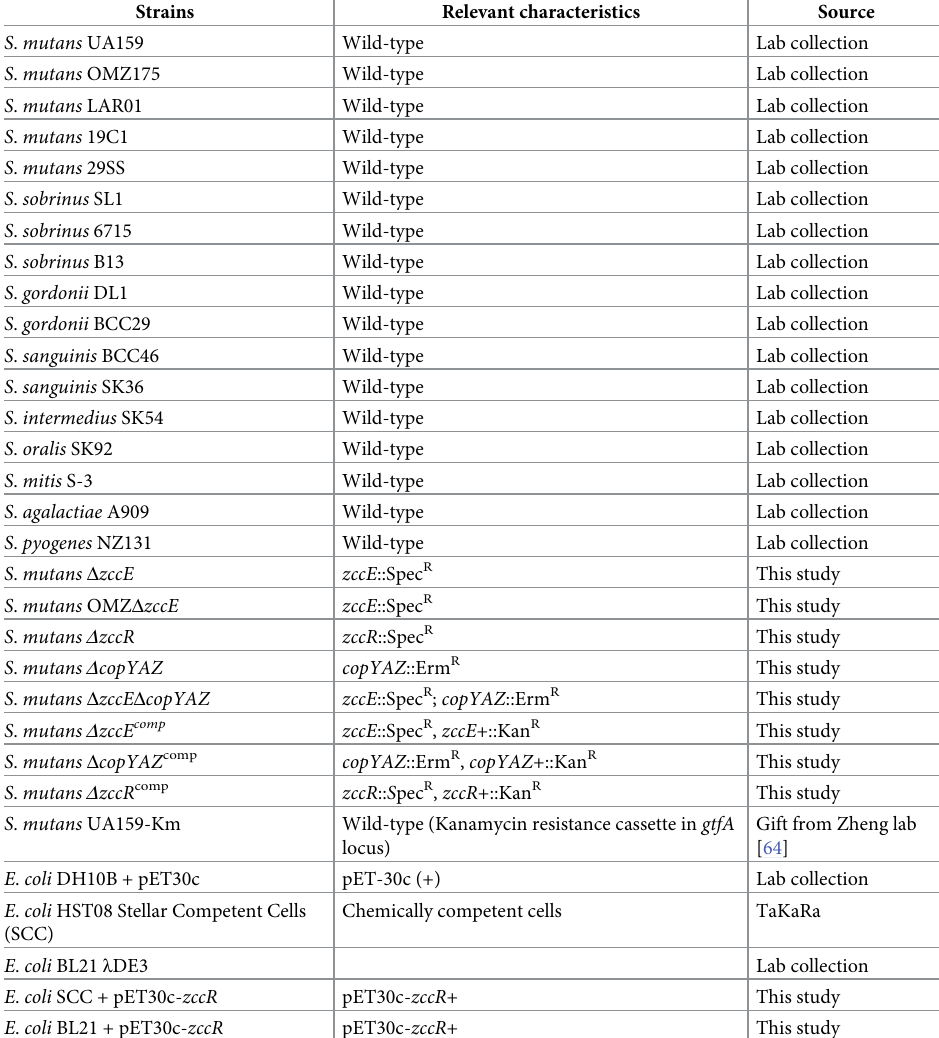
Table 2. Bacterial strains used in the